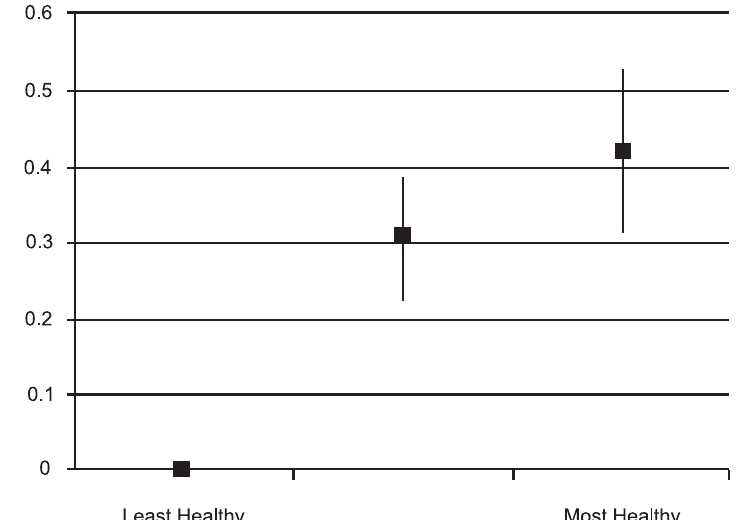
Figure 1. Cross-sectional associations between Healthy diet scores and PedsQL scores (z-score standardized) after adjustments for gender, age, dieting behaviours, BMI, SES and PA.